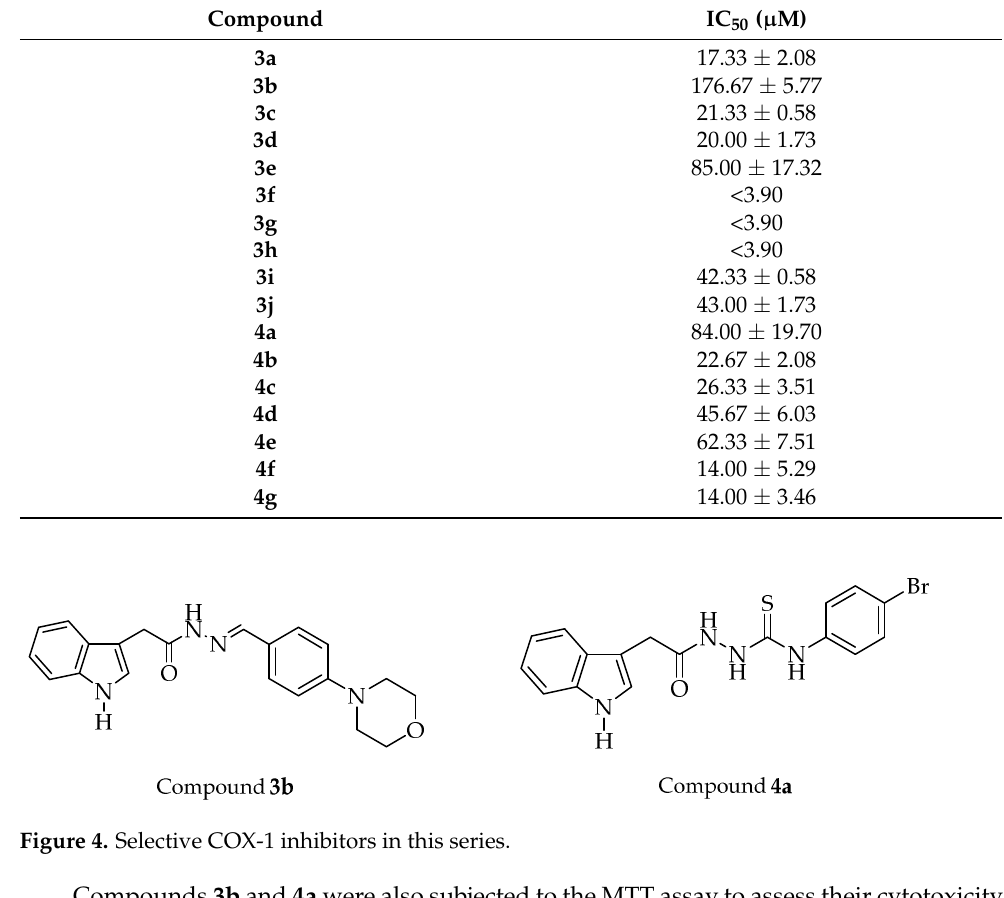
Table 3. IC 50 values of all compounds for L929 cells.